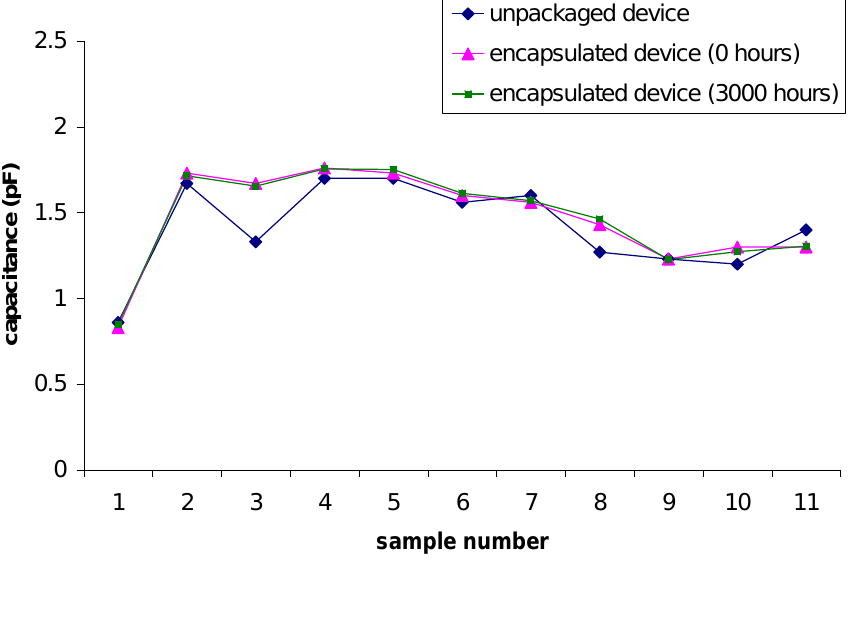
Figure 9. Plot showing comparison of capacitance value between unpackaged and encapsulated MEMSTech 50g accelerometer, both at 0 and 3,000